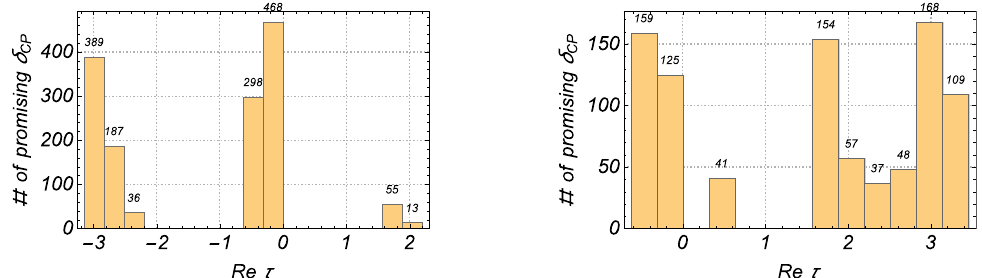
Figure 6 . Left panel: frequency of Re τ satisfying an inequality in eq. (4.8) for Im τ = 1 . 8 in Pattern I. Digits on the top of histogram bins denote the numbers of combinations of Higgs VEVs. Right panel: the same one for Im τ = 2 . 0.